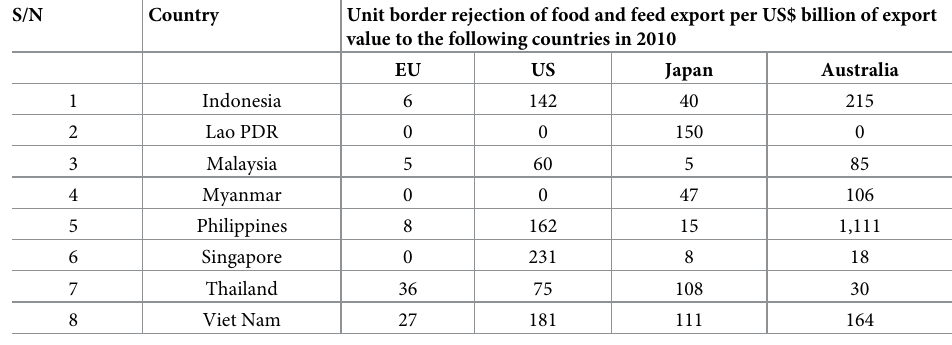
Source : UNIDO working paper